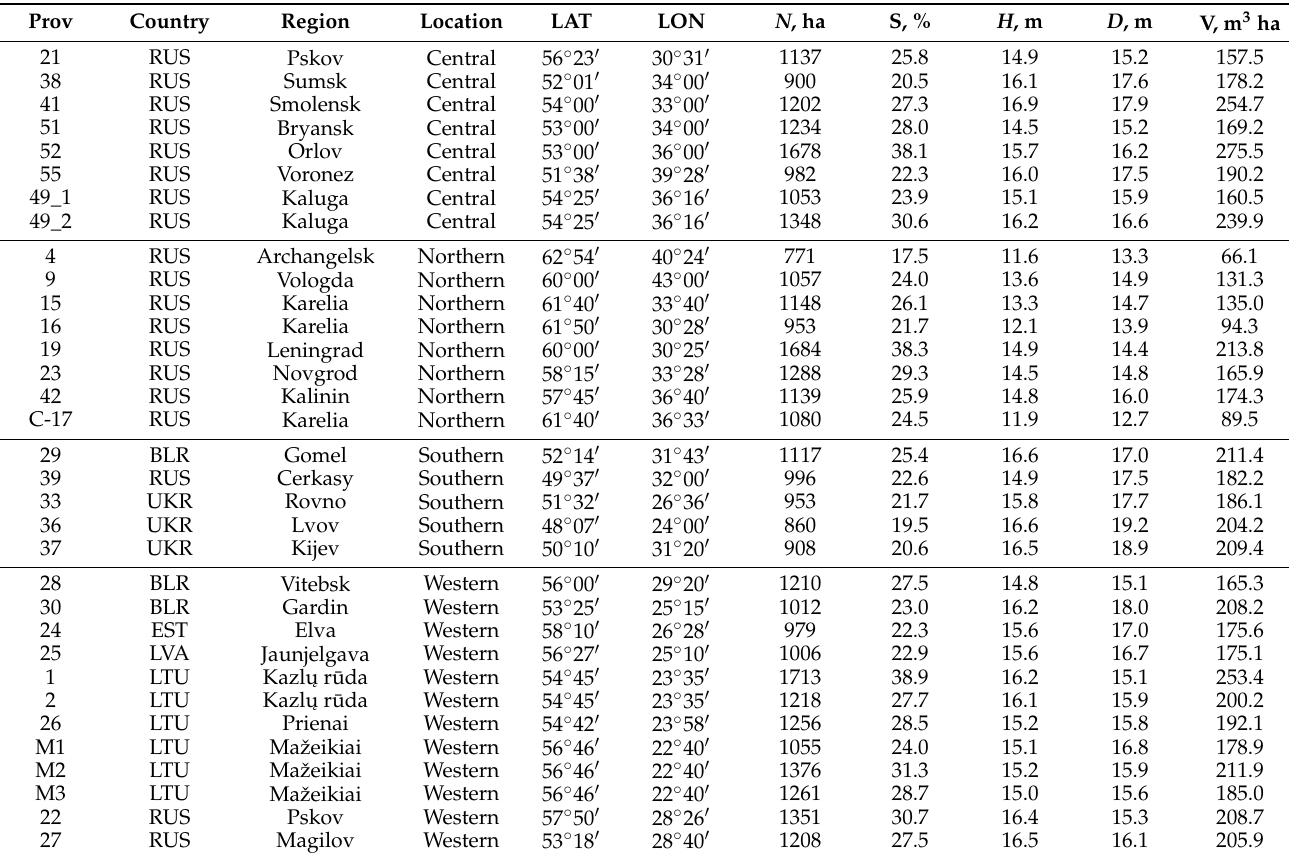
stem radial growth. The following column abbreviations were used: Prov—number of Scots pine provenances, LAT—altitude, LON—longitude, N —number of trees per hectare, S—survival rate, H —mean height, D —mean diameter, V—volume of growing